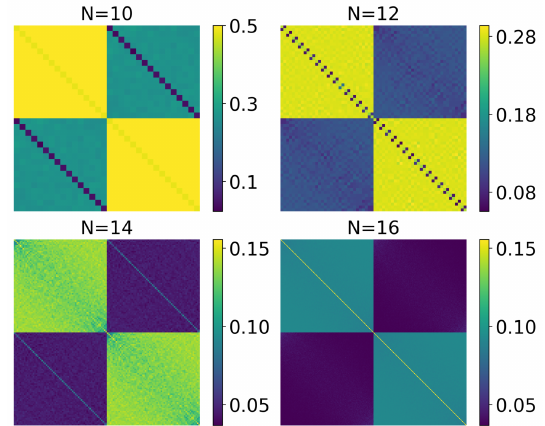
Figure 17 . The R mn matrix for q = 4 SYK model, featuring an extra fermion number symmetry F . The eigenvectors are organized into the even and odd symmetry sectors. The average value of the off-diagonal matrix elements becomes suppressed as N increases. For N = 2 , 6 mod 8 , the even and odd symmetry sectors are exactly equal (appendix B).